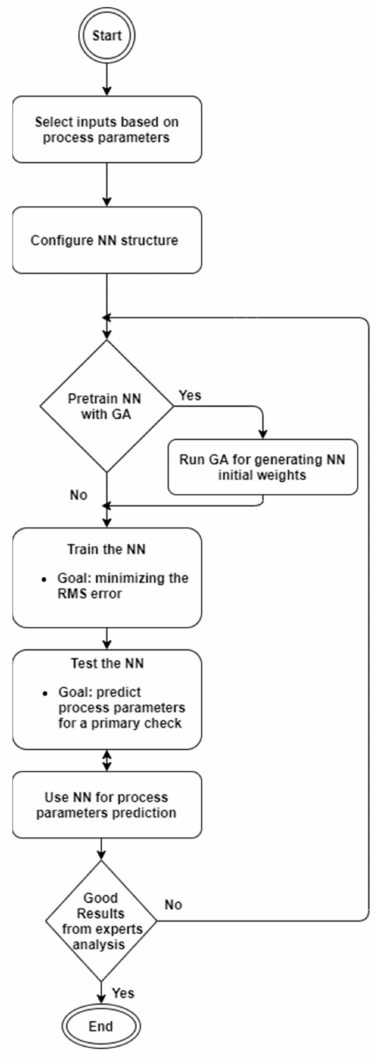
Figure 1. Experiment